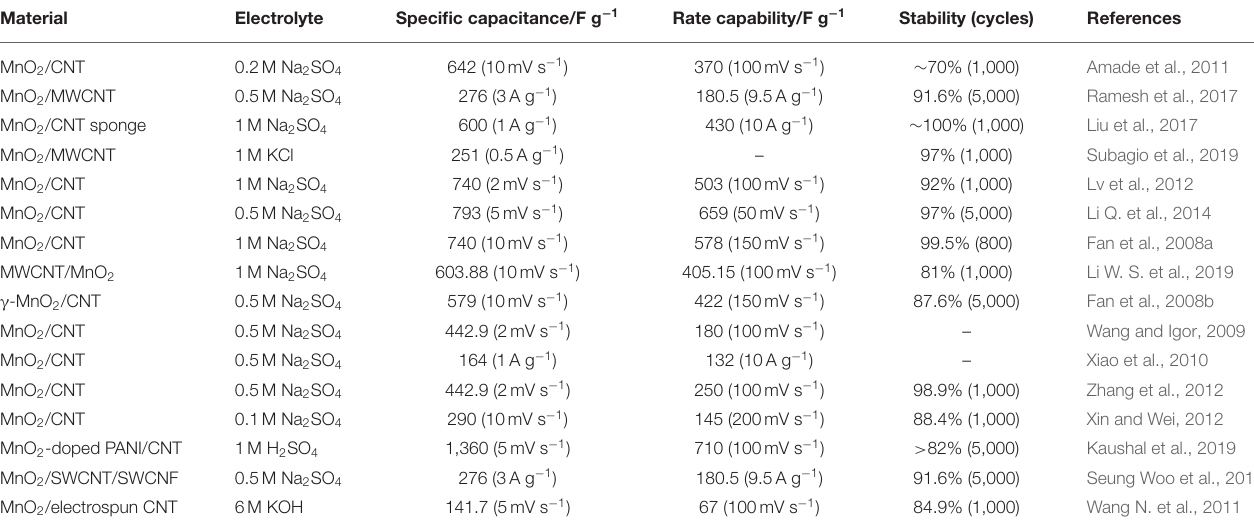
TABLE 1 | Electrochemical performance of various MnO 2 /CNT materials.